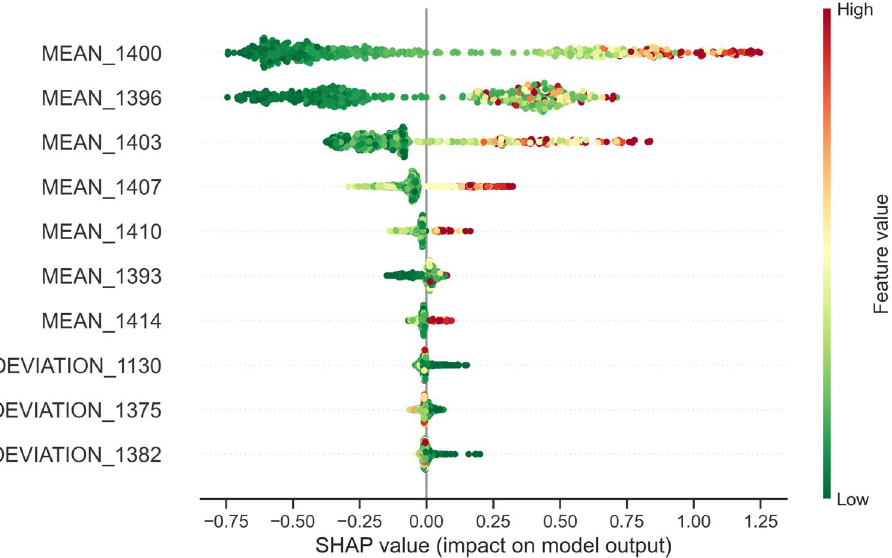
Figure 13. The 10 most important features, listed from top to bottom, and their contribution. Dots visualized in each row, corresponding to a specific feature, represent feature values of all the training samples.